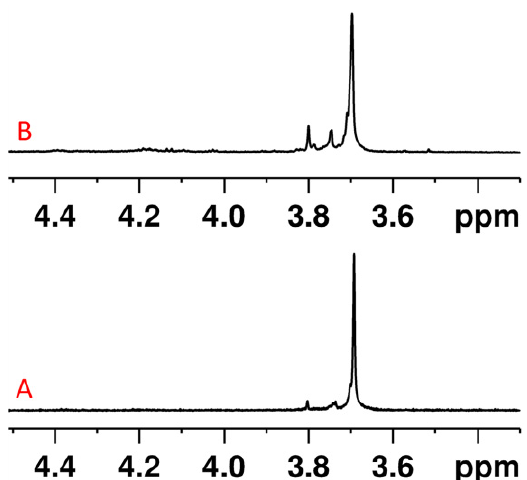
Figure 3. Methoxy region of the 1 H NMR (CDCl 3 , 600 MHz, T = 298 K) spectra of the pentane-insoluble ( A ) and pentane-soluble ( B ) fractions of the copolymer sample of run 2, Table 1.